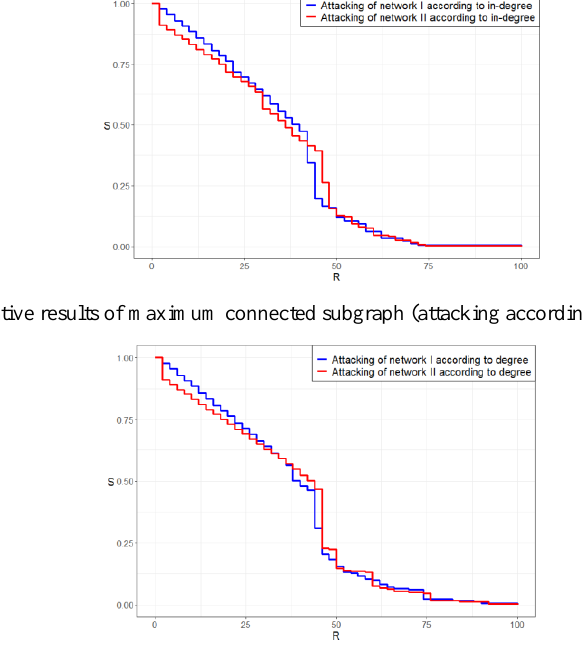
Fig. 9. The relative results of maximum connected subgraph (attacking according to out-degree).